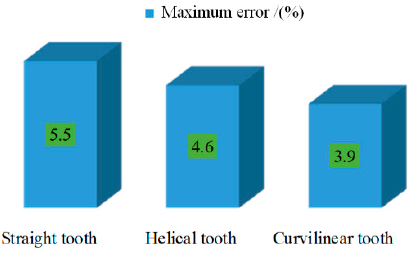
Figure 19. Maximum relative error of the transmission ratio experiment.